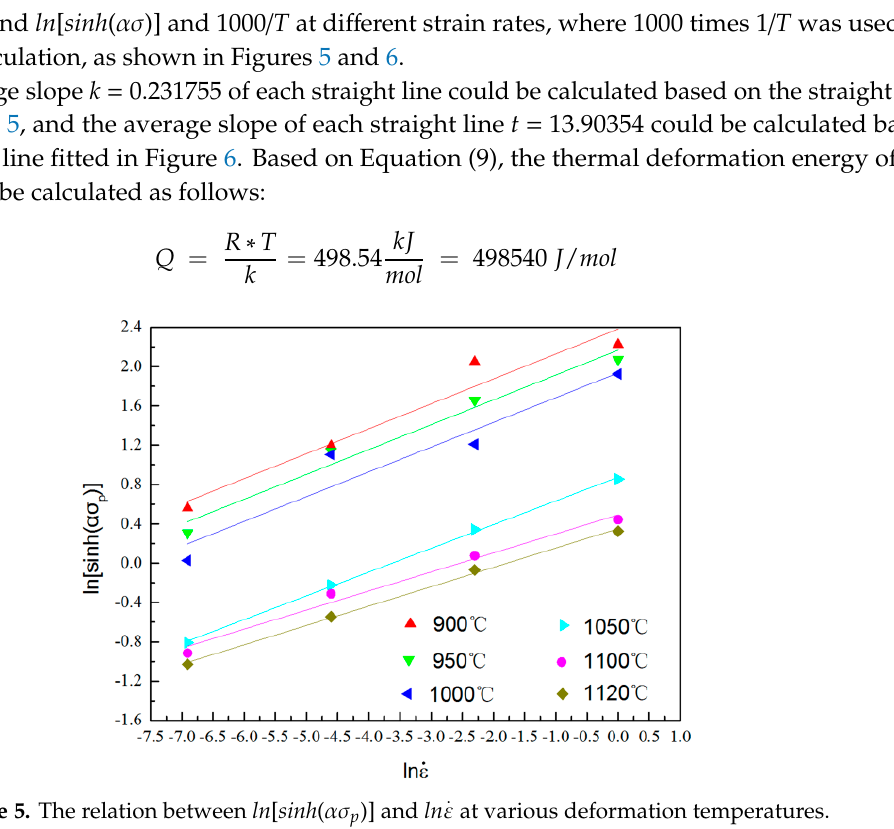
Figure 5. The relation between ln [ sinh ( ασ p )] and 𝑙𝑛𝜀(cid:4662) at various deformation temperatures.